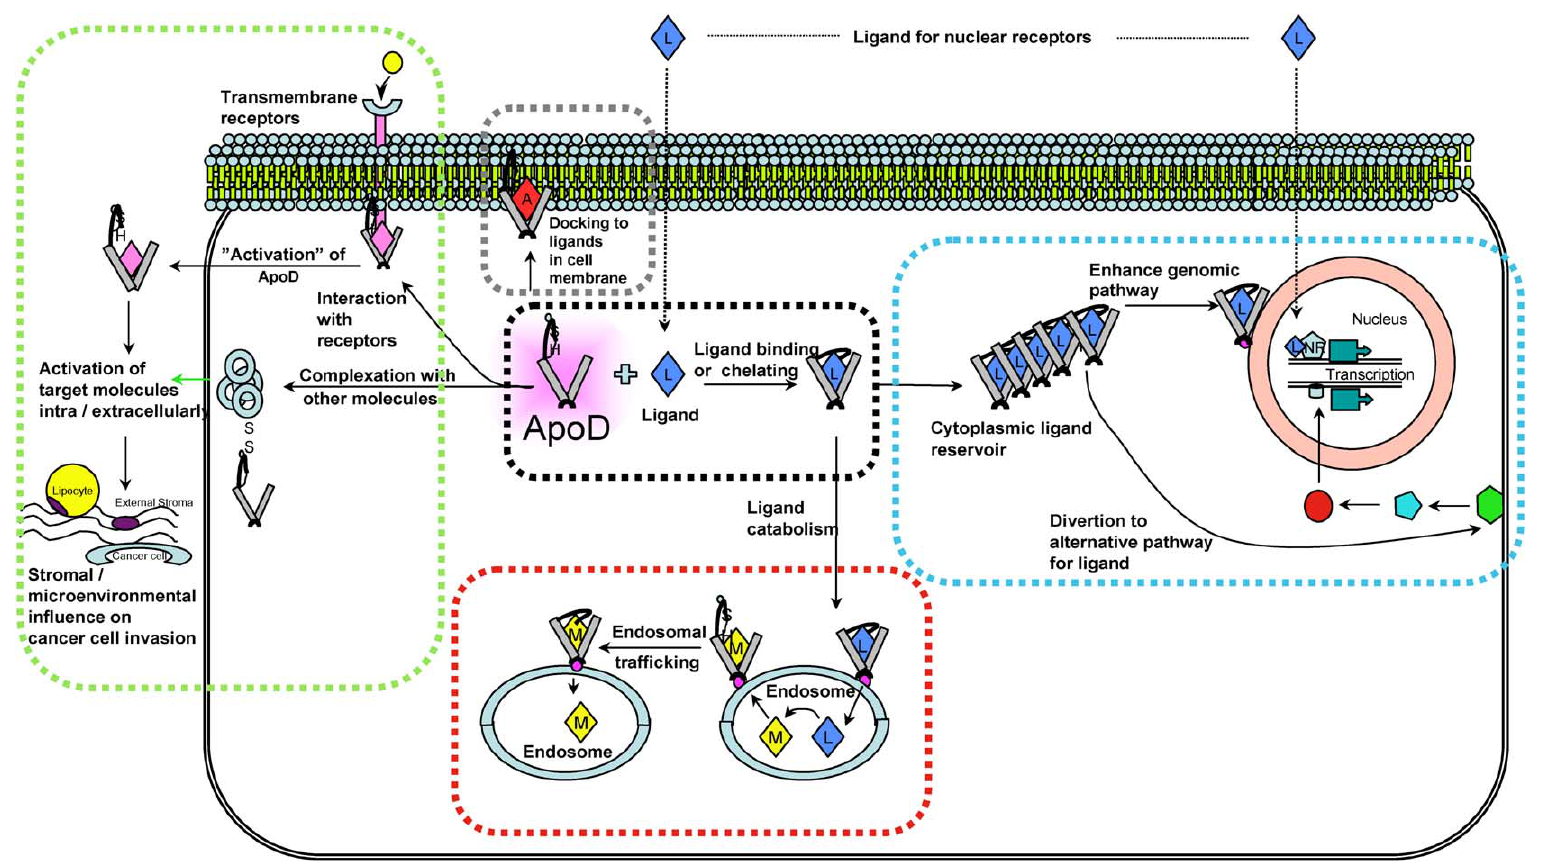
Fig. 8. General mechanistic model of cellular actions of ApoD. ApoD may be produced locally in a cell, secreted to or taken up from juxta cellular micro-environment. Black dotted rectangle: In the cell, generally ApoD may bind hydrophobic ligands. Blue dotted rectangle: The ligand bound to ApoD may be built up as an intracellular reservoir that can increase the effect on gene transcription of nuclear receptor ligands. Alternatively this cytoplasmic reservoir may divert the ligand to alternative pathways. Red dotted rectangle: ApoD is able to exert endosomal trafficking, and may take part in chelating and diverting ligands to its metabolic pathways. This may also include drugs administered. Grey dotted rectangle: ApoD is also able to dock to cellular membrane molecules and may stabilize these molecules and hence be a regulator of the turnover of such molecules. Green dotted rectangle: Moreover, possible interactions with transmembrane receptors are suggested to take place and ApoD may form complexes with other molecules either inside or outside the cell that are involved in the micro-environment of the cancer cell. Abbreviations: L in blue diamond: ligand for nuclear receptors; M in yellow diamond: metabolite of ligand (L); A in red diamond: intramembranous